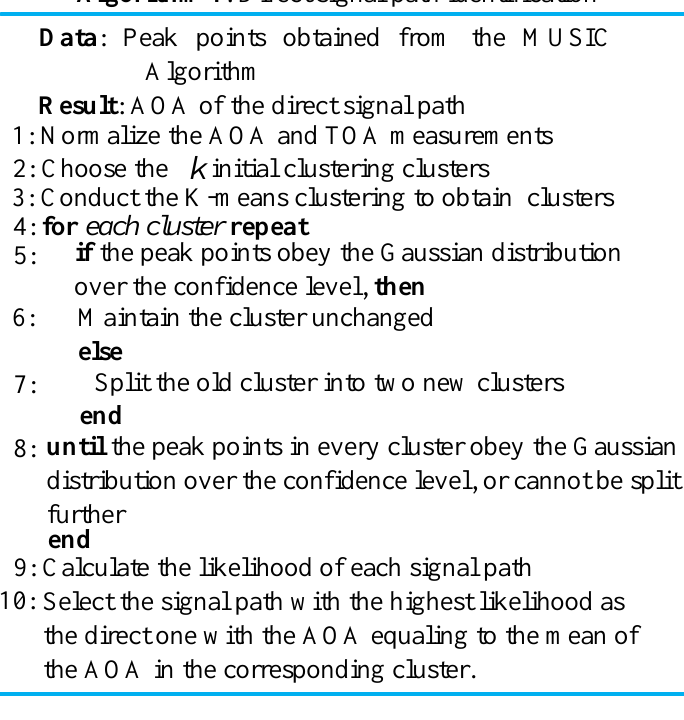
Figure 9. Direct signal path identification algorithm.